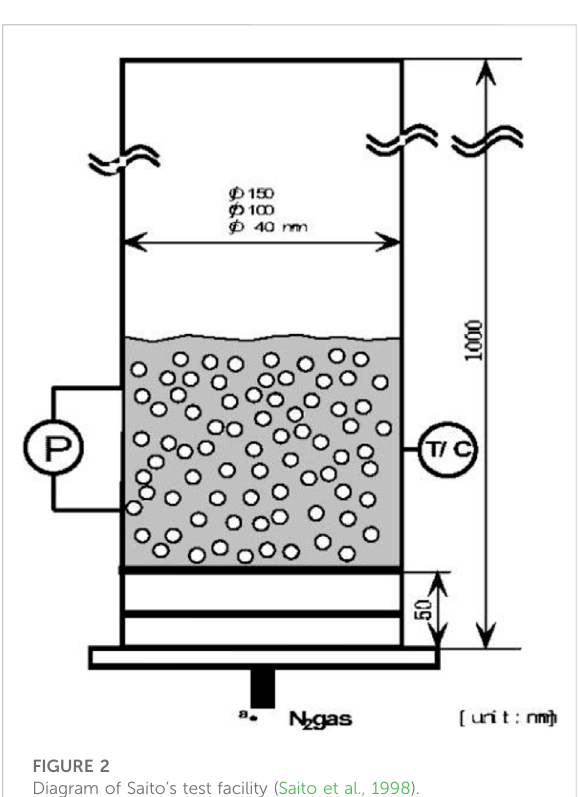
FIGURE 2 Diagram of Saito ’ s test facility (Saito et al.,